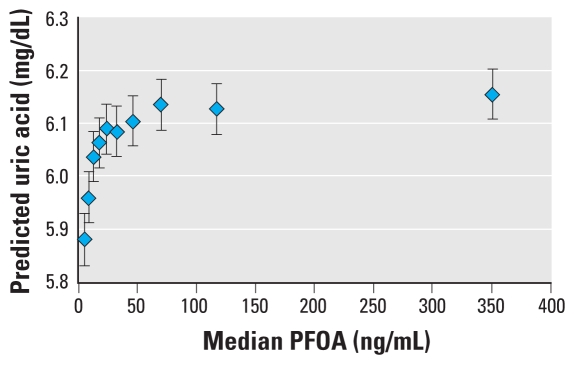
Predicted uric acid with increasing PFOA. Predicted value from regression model for an average participant: 45 years of age, 0.95 mg/dL creatinine, high school education, male, 28.55 kg/m2 BMI, nonsmoker, nondrinker. Data are population means and 95% CIs.